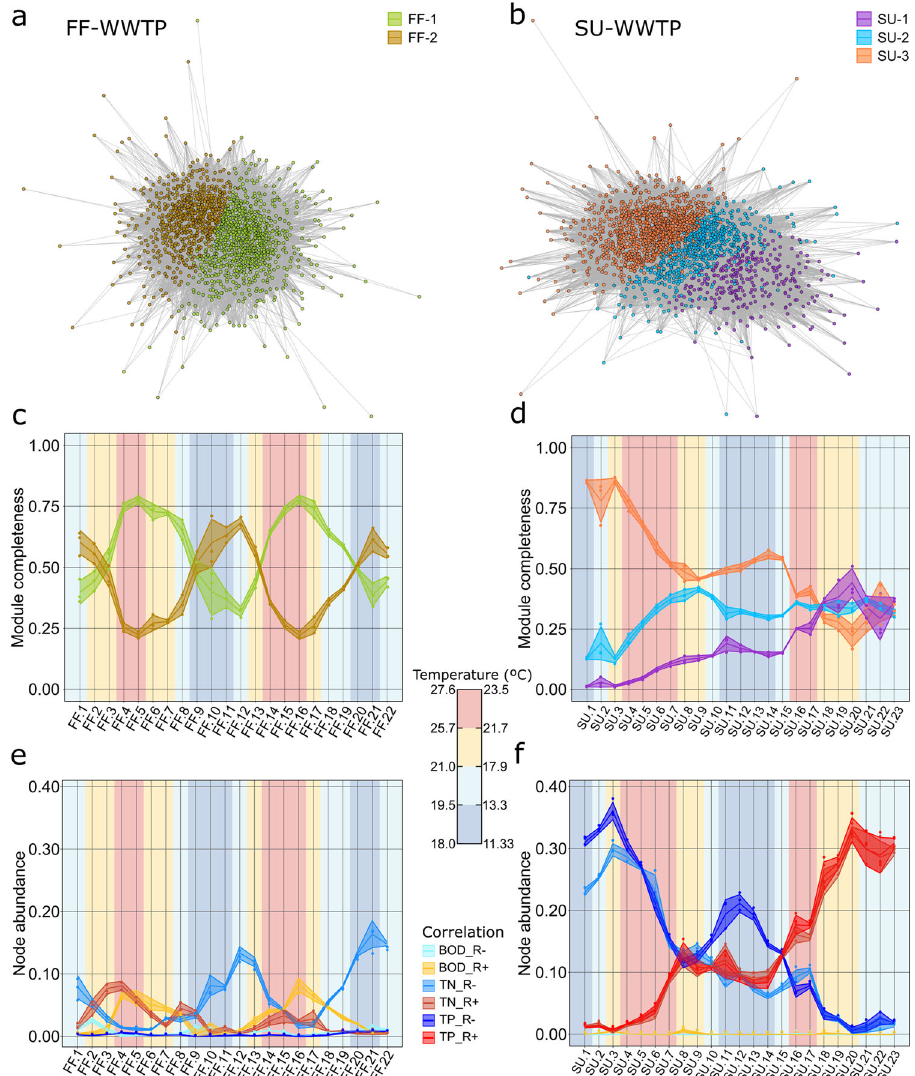
Fig. 1 Ecological clusters based on co-occurrence patterns. The left panels represent data from the fully functional plant (FF-WWTP), and the right panels represent the starting up plant (SU-WWTP). Network nodes represent community members (ASV) and edges signi fi cant relationships between nodes (probability of co-occurrence higher than 0.95). a , b Nodes are colored based on their module membership, being FF-WWTP divided in two different modules (FF-1, green and FF-2, brown) and SU-WWTP in three (SU-1, purple; SU-2, blue; and SU-3, orange). c, d Module completeness, the proportion of nodes belonging to a given module present in each individual sample. e , f Abundance of nodes correlated to any given pollutant removal rate. The central lines correspond to average values ( n = 3) of each sample, and the shaded areas correspond to the standard deviation. The background of the plots is colored based on the temperature measured when collecting samples. Temperature data were divided in quartiles (between 18.0 and 27.6 °C for FF-WWTP and, between 11.33 and 23.50 °C for SU-WWTP) for a simpler representation. Temporal sampling frame includes a 2-year monthly sampling from April 2017 to March 2019 (August not sampled) for FF-WWTP and from March 2017 to February 2019 (June 2019 not sampled) for